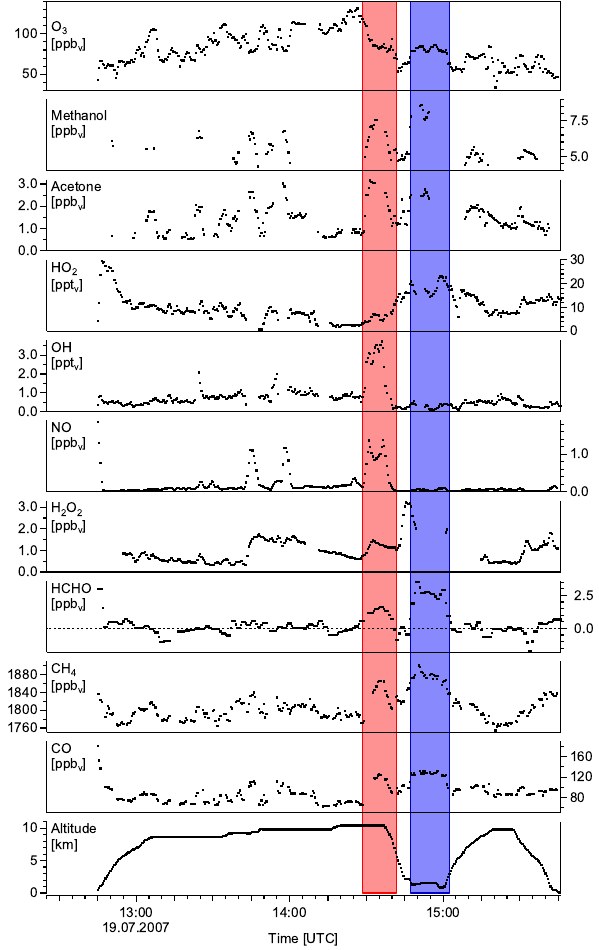
Figure 6. Time series of parameters measured on 19 July 2007. The red area marks the outflow region, the blue area the inflow